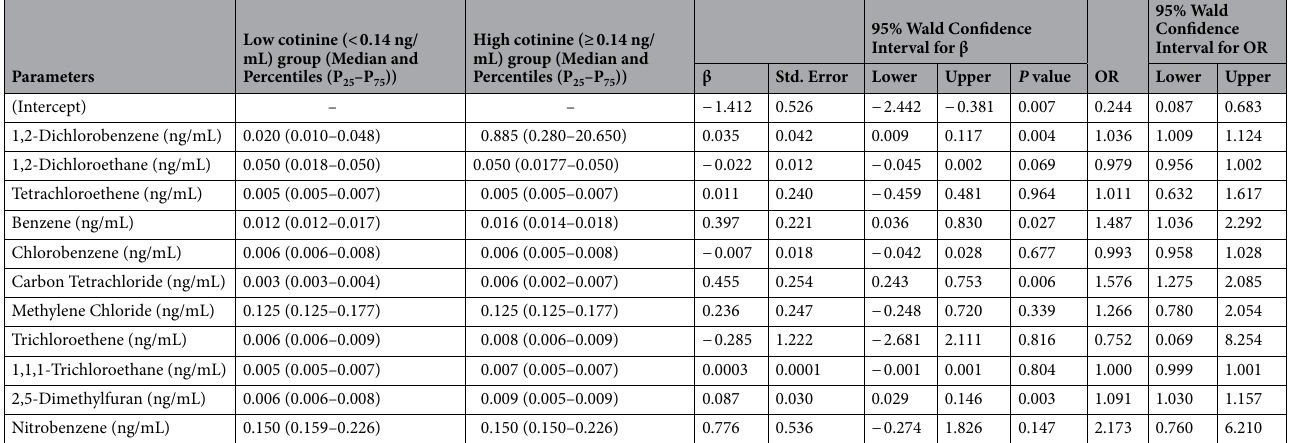
Table 1. Association between serum VOCs and cotinine levels in 3114 smokers † . † Multivariable logistic regression analysis adjusted for age, gender, race/ethnicity, education, family poverty index ratio (PIR), depression status, and drug use history were adjusted. Std. Error, standard error; OR, odds ratio; N, sample